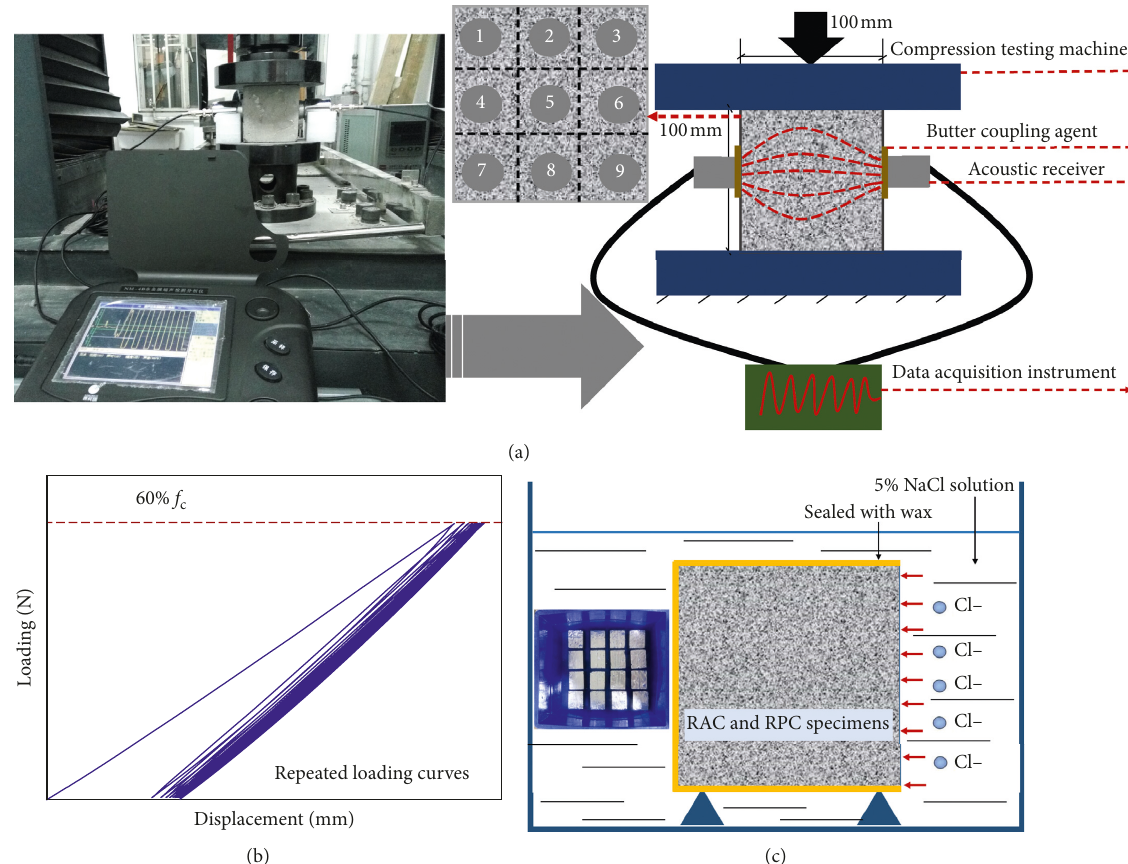
Figure 3: Test methods and equipment. (a) The loading test and the testing method for imposing load damage. (b) Repeated loading curves. (c) Chloride ion diffusion